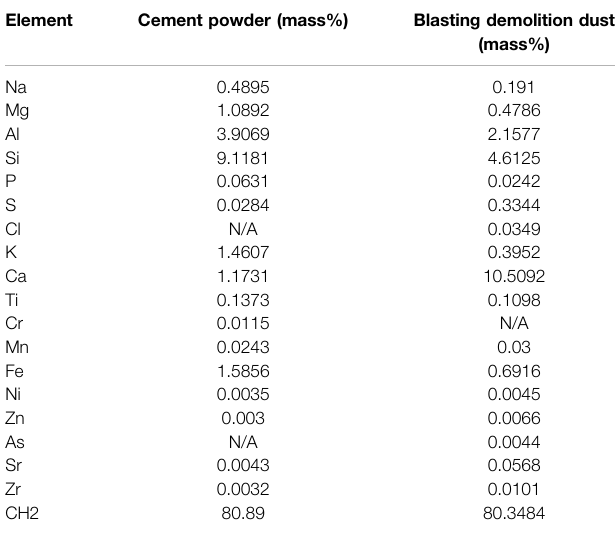
TABLE 2 | Mass concentration of elements of cement powder samples and BDD samples (CH2 represent the mass percentage of other elements other than the indicated 18 elements among elements No. 9-No.92).